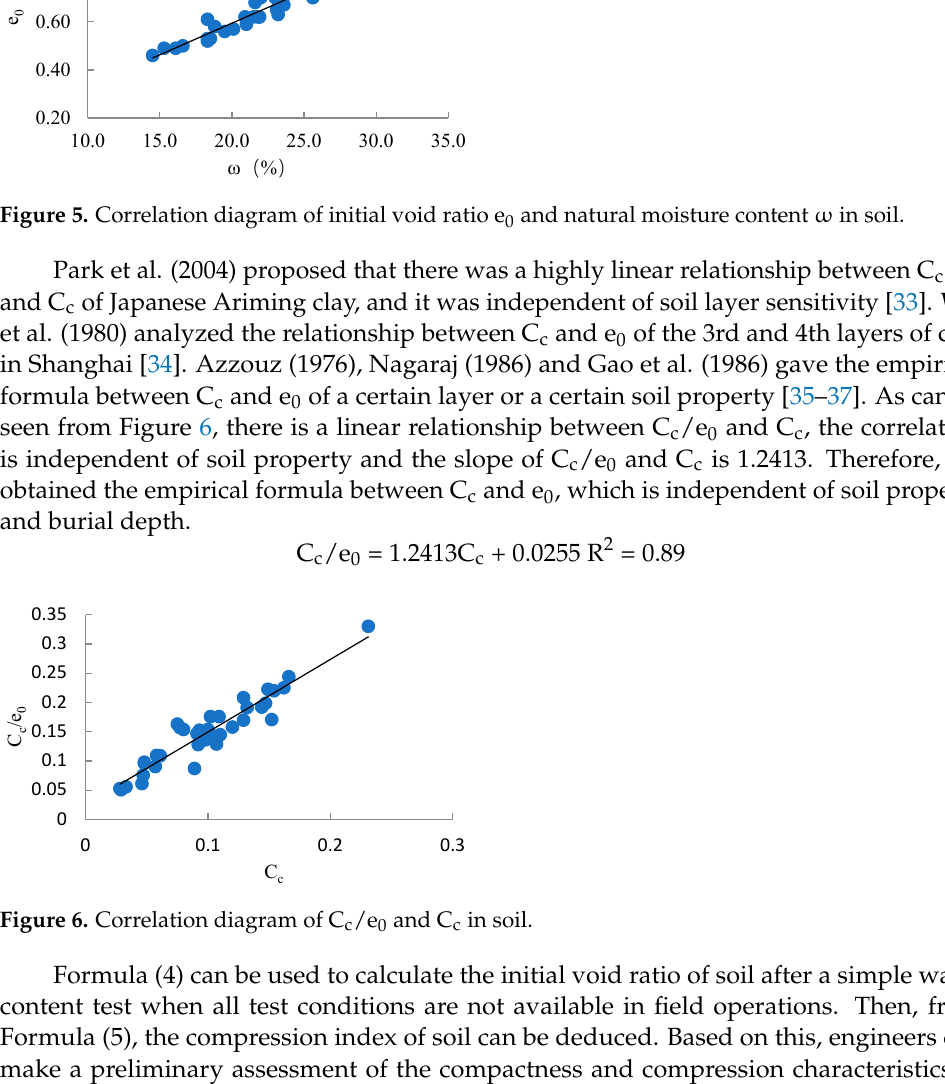
Table 4. Relationship between soil secondary consolidation index and compression index.